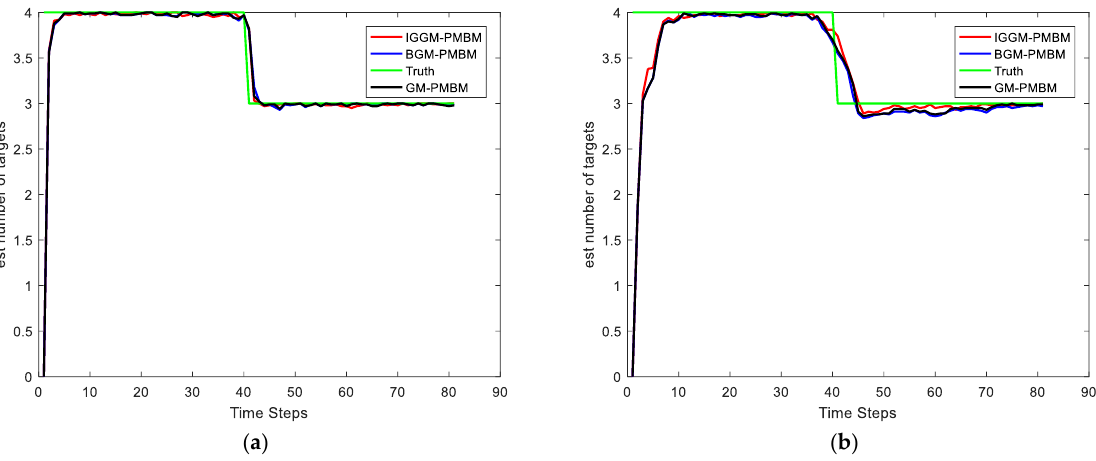
Figure 3. The estimated average number of targets in 100 Monte Carlo runs. ( a ) 𝑃 𝐷 = 0.94 , 𝜆 𝜅 = 10 ; ( b ) 𝑃 𝐷 = 0.68 , 𝜆 𝜅 = 10 .